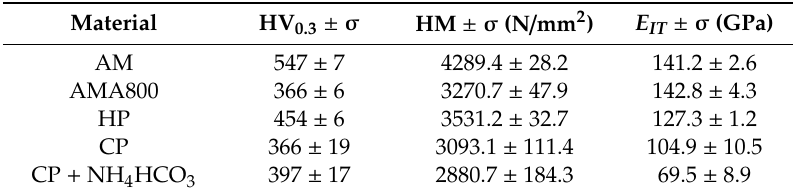
Table 3. Vickers hardness (HV 0.3 ), Martens hardness (HM), and Young’s modulus ( E IT ) of the Ti23Mo alloys obtained by different processing approaches.